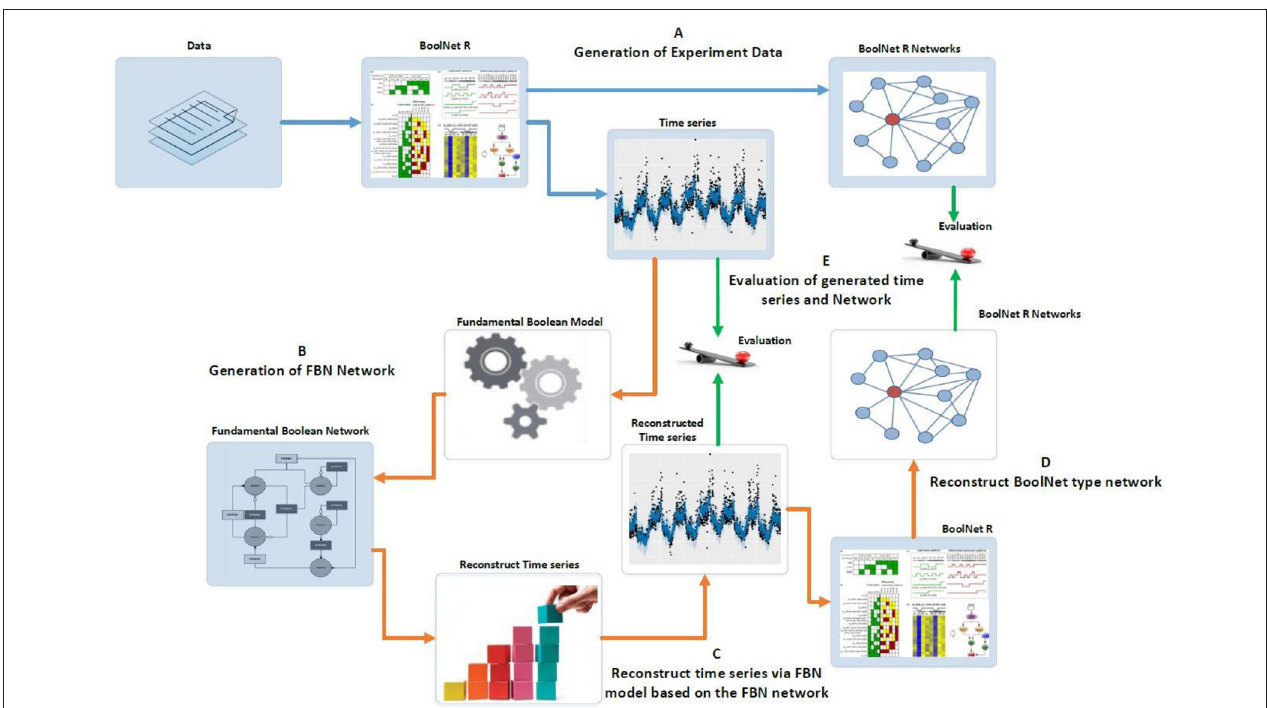
FIGURE 7 | Experiment design of evaluating the Fundamental Boolean network inference. The blue arrows represent the processes using BoolNet and brown arrows represent the processes using our FBNNet tools. The green arrows represent the evaluation process. (A) We use the BoolNet script loadNetwork.R to load pre-defined networks from files and then generate the time series and networks. (B) We use the time series generated from BoolNet and the new R package, FBNNet, to generate FBNs. (C) We reconstruct the time series via the FBM. (D) To evaluate the FBM, we rebuild the BoolNet type network based on the reconstructed time series; and (E) we evaluate the FBN inference methods by comparing the generated time series and the generated BoolNet type of network with the original time series and network that were generated in step